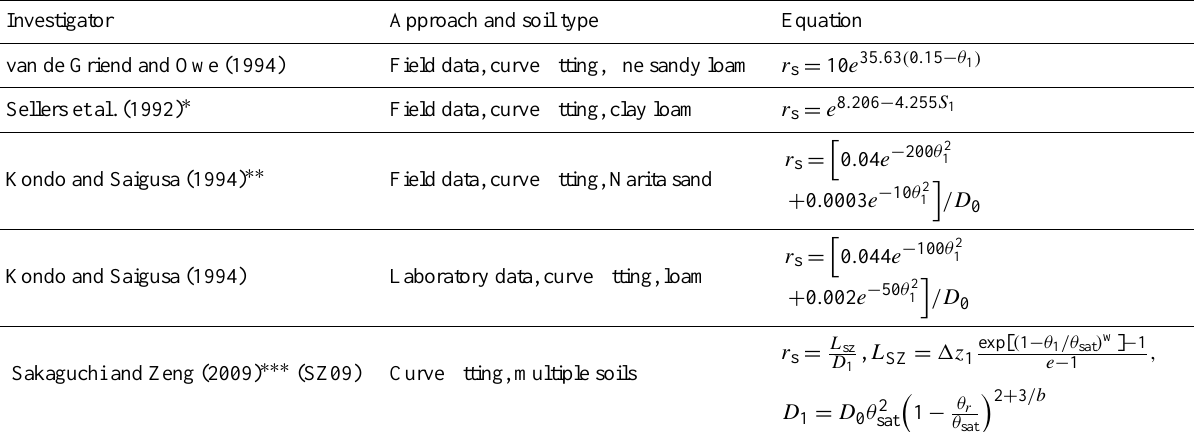
Table 1. A list of existing formulations of soil resistance identified from literature